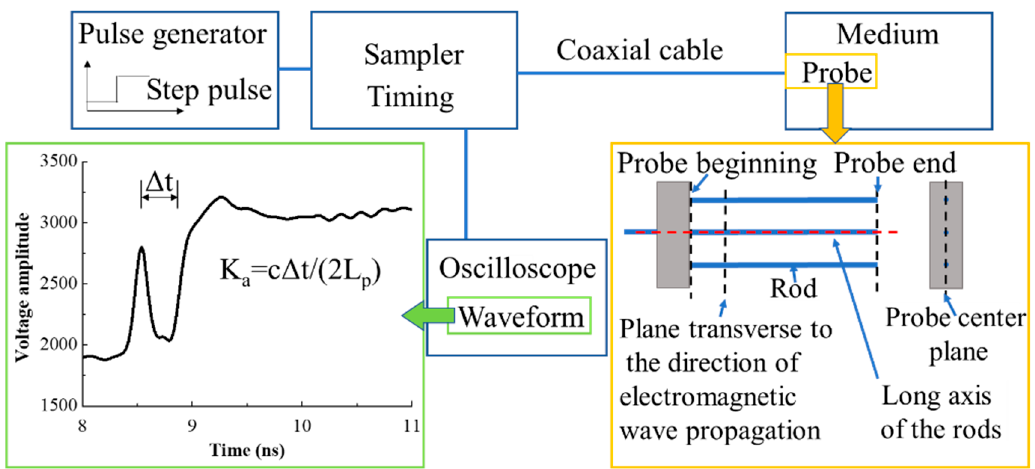
Figure 1. A schematic diagram of the time domain reflectometry (TDR) device and the waveform. Δ t: travel time.